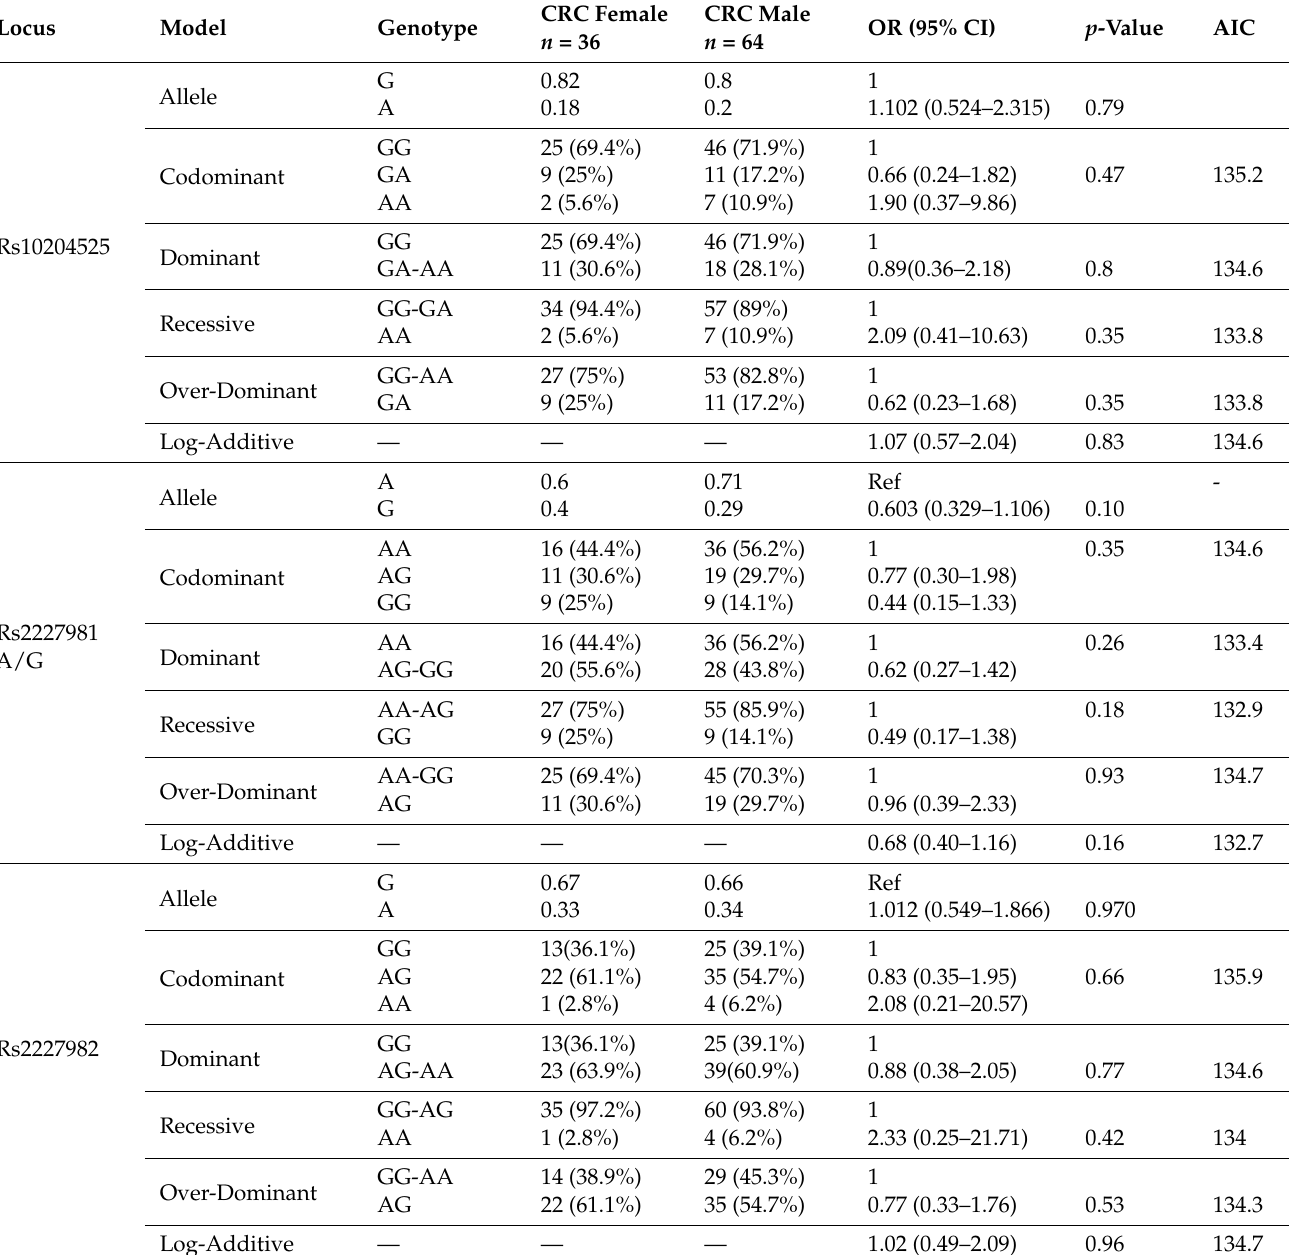
Table 5. Association of PD-1 SNP polymorphisms with CRC after gender